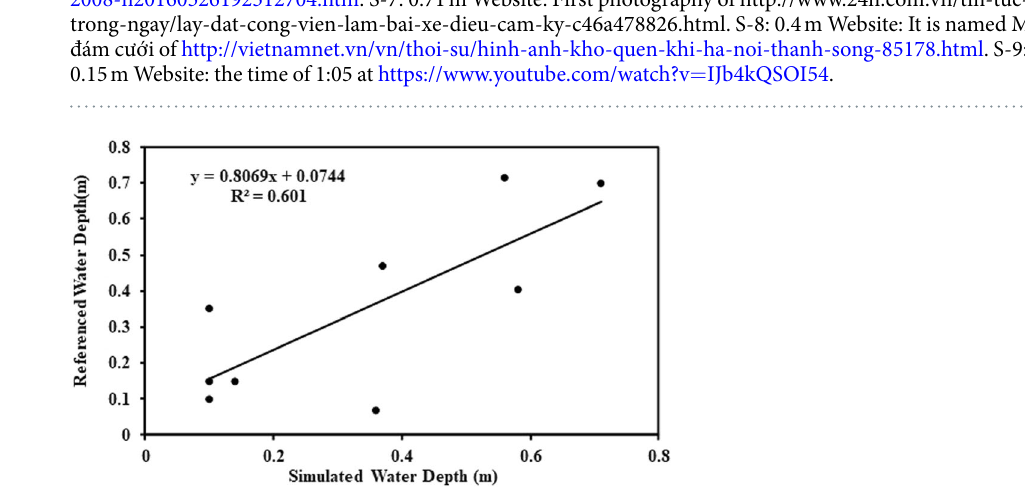
Figure 4. Regression relationship between simulated water depth and referenced water depth for 9